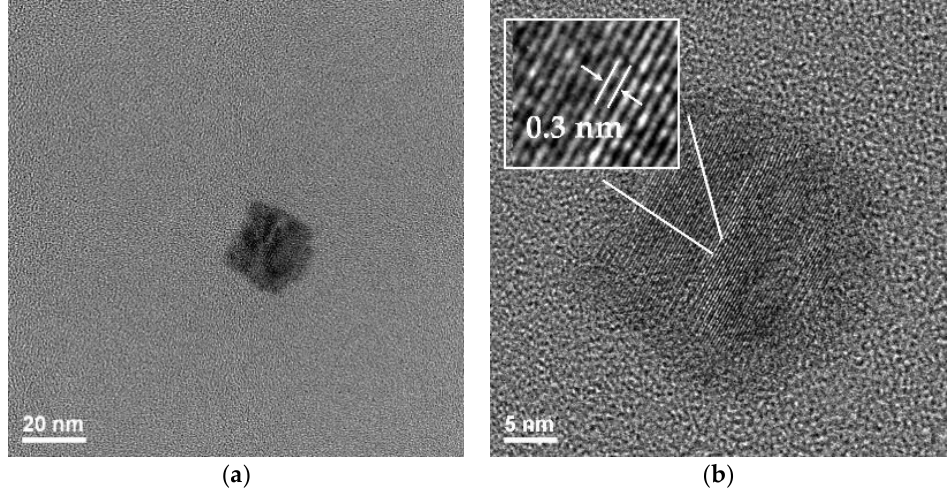
Figure 2. ( a ) TEM image of CsPbI 3 QD nanocrystals with the diameter of approximately 16 nm. ( b ) HR-TEM of image (a) and enlarged image (insert).